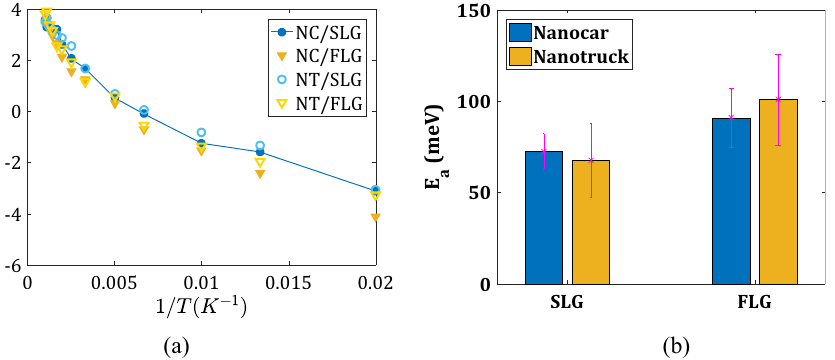
Figure 5. Quantification of nanomachines’ lateral mobility: ( a ) Arrhenius plot of Nanocar and Nanotruck diffusion coefficients on two substrate types (SLG—blue, FLG—yellow); ( b ) activation energies computed for all